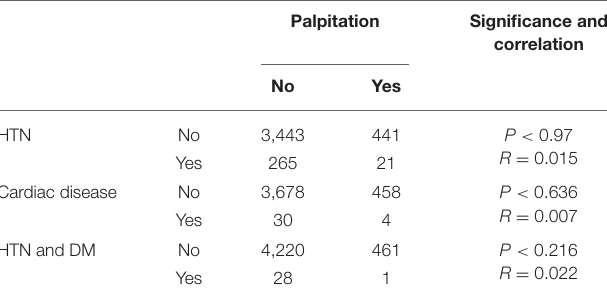
TABLE 5 | Relationship between palpitation and the presence of hypertension, and cardiac disease in the tested subjects. Palpitation Significance and correlation